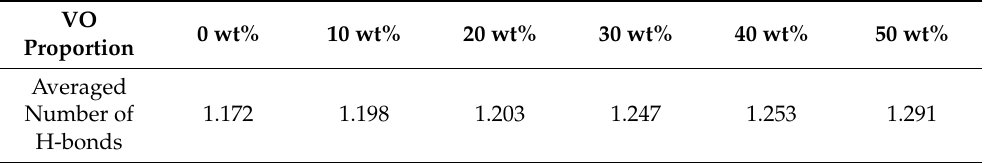
Table 10. The average number of H-bonds per water molecule in mixed oil models with 3wt% of water